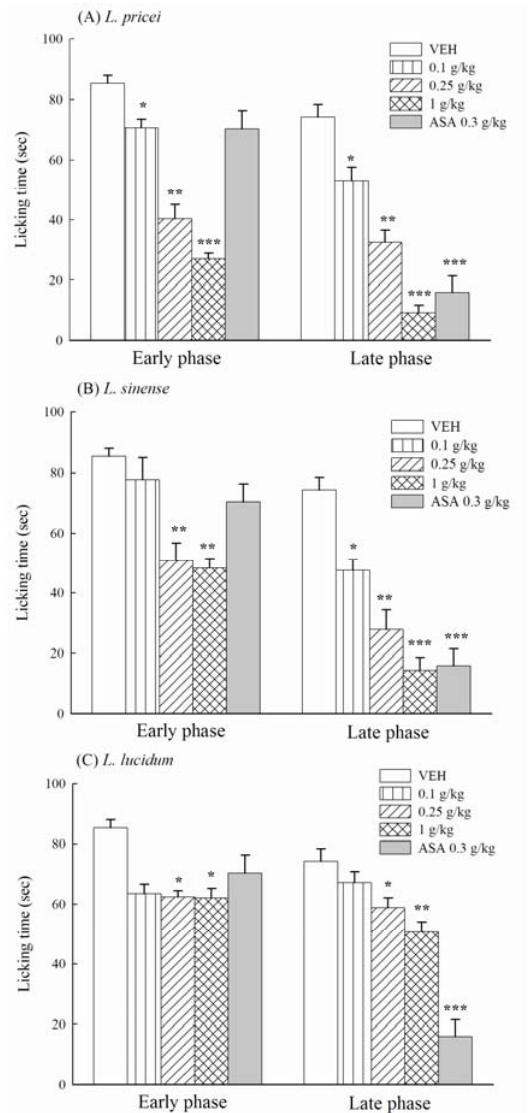
Figure 2. Effects of methanol extracts from Ligustrum plants leaves (0.1, 0.25, 1 g/kg)